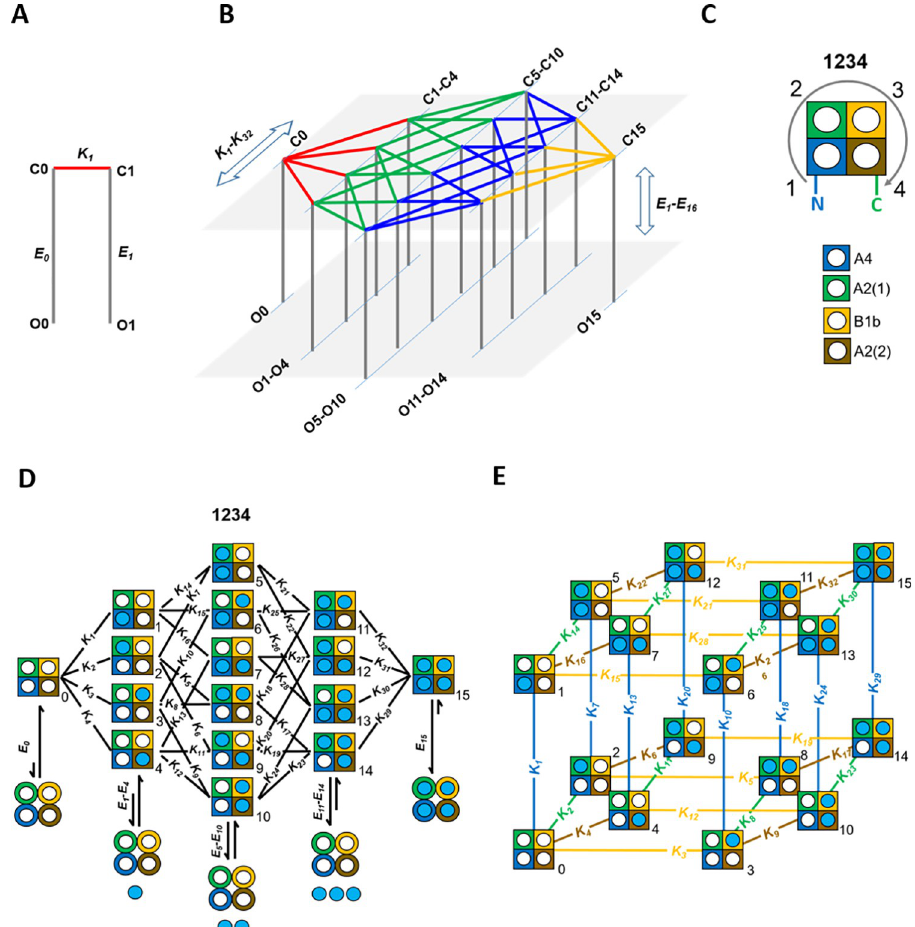
Fig 1. State models for the activation in heteromeric proteins. ( A ) Scheme with two closed and two open states (C0, C1, O0, O1) for a theoretical minimum ligand-gated channel. There is one ligand binding step from closed state C0 to closed state C1, specified by the equilibrium association constant K 1 . From each closed state an opening step is possible and E . ( B ) Related scheme for a that is specified by the respective closed-open isomerization constant E 0 1 heterotetrameric channel containing 16 closed (C0-C15) and 16 open states (O0-O15), requiring for the closed channel 32 binding steps ( K - K ) and 16 allosteric opening steps ( E - E ). ( C ) Cartoon scheme of the concatamer 1 32 0 15 used in the analysis with the sequence N-A4-A2(1)-B1b-A2(2)-C [31]. The colors of the subunits are used throughout the article. ( D ) Detailed cartoon scheme for the concatameric heterotrameric allosteric (HA) model used in the analysis, specifying the counting of the 32 K x and the 16 E x , here summarized at equal degree of liganding. ( E ) Representation of the scheme in d in a 4D hypercube to ease the analysis.